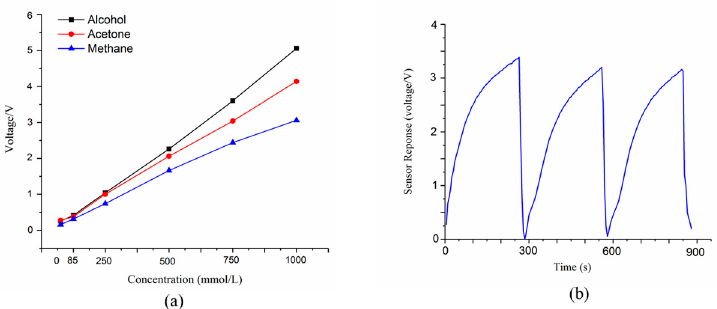
Figure 3. Sensor training of sensor MQ 138 towards pure gases with different concentrations ( a ), and the reproducibility test of sensor MQ 138 under exposure to healthy tomato plant ( b ).